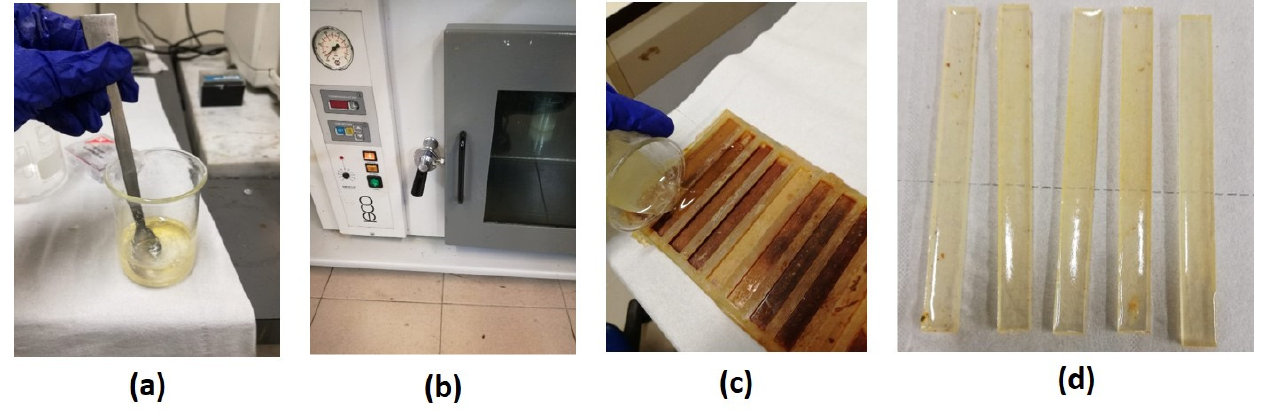
Figure 1. Mixing ( a ), vacuum ( b ), and pouring in silicon molds ( c ) cured thermoset samples ( d ).